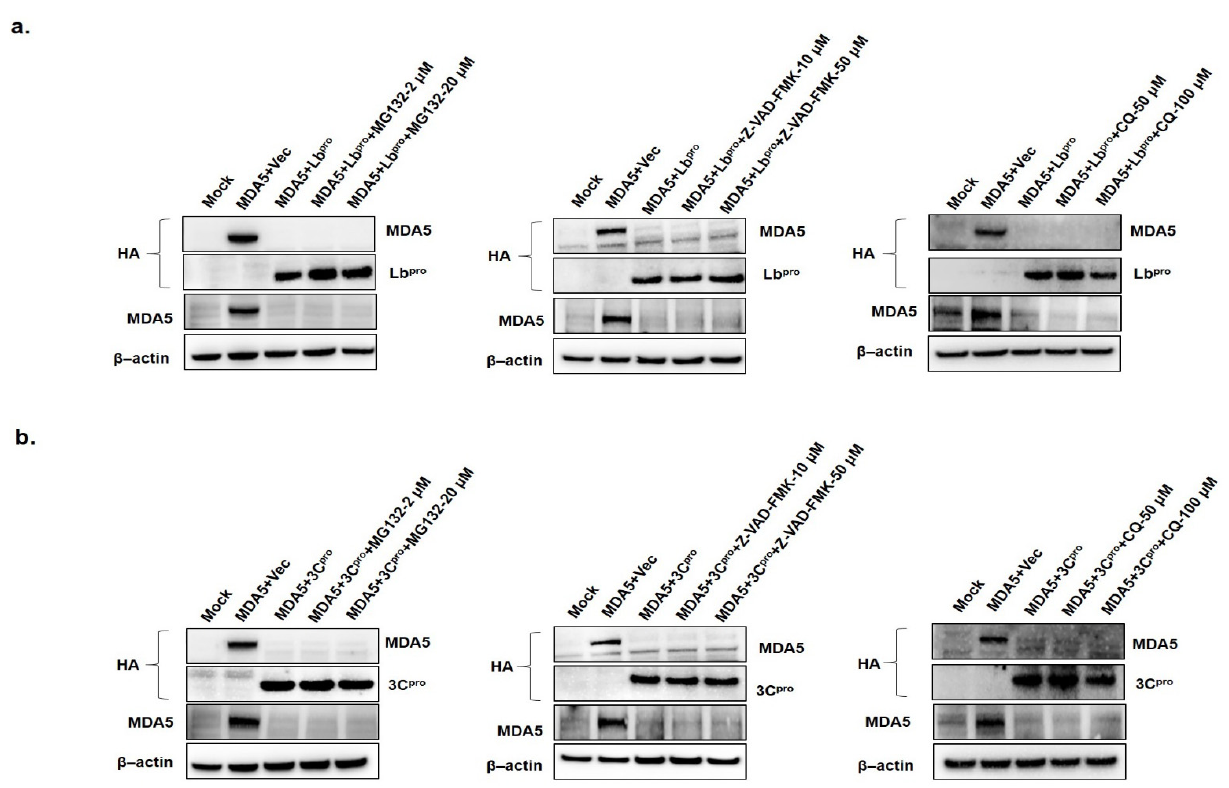
Figure 4. The effects of proteasome, lysosome and caspase inhibitors on Lb pro - or 3C pro -induced MDA5 reduction. ( a ) HEK293T cells (1.5 × 10 6 cells) were mock-transfected or were co-transfected with HA-MDA5-expressing plasmid (2 µg) and empty vector (2 µg) or HA-Lb pro expressing plasmids (2 µg). Cells were maintained for 12 h in the presence or absence of the proteasome inhibitor MG132 (2 or 20 µM), the caspase inhibitor Z-VAD-FMK (10 or 50 µM) or lysosome inhibitor chloroquine (CQ; 50 or 100 µM). ( b ) HEK293T cells (1.5×10 6 cells) were mock or co-transfected with HA-MDA5-expressing plasmid (2 µg) and empty vector (2 µg) or HA-3C pro expressing plasmid (2 µg) and maintained in the presence or absence of MG132 (2 or 20 µM), Z-VAD-FMK (10 or 50 µM) or CQ (50 or 100 µM). The protein levels of the above-described experiments were determined by Western blotting with anti-HA, MDA5 and β -actin antibodies. All the data were repeated in three independent experiments and data from one of the triplicate experiments are shown.